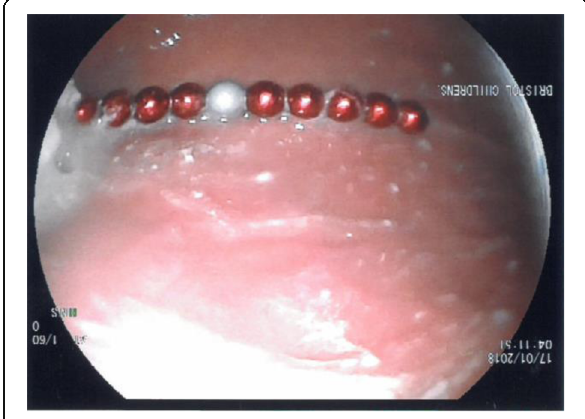
Fig. 1 Endoscopic image of a chain of 18 Buckyball magnets inside the stomach of a child Fig. 2 One spare Buckyball magnet inserted into a retrieval